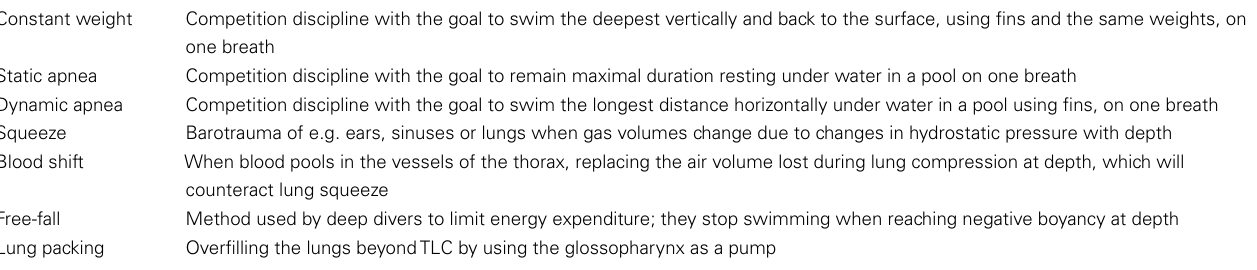
Table 2 | Disciplines and explanation of some special terms used in sports apnea (see also Schagatay, 2009, 2010, 2011). Constant